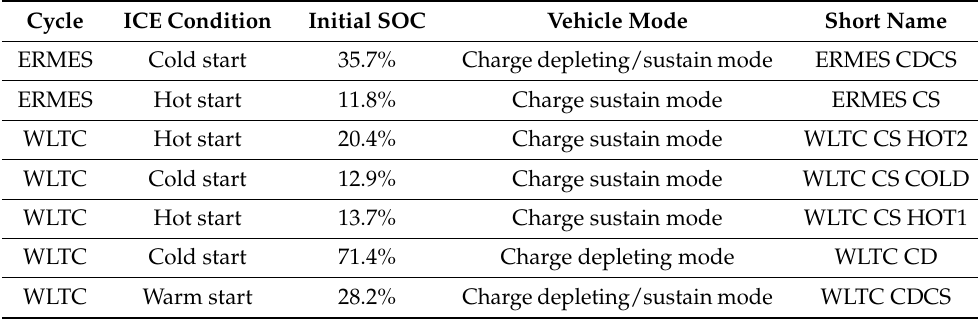
Table 2. Driving cycles and specifications use for experimental validation of the back-engineered